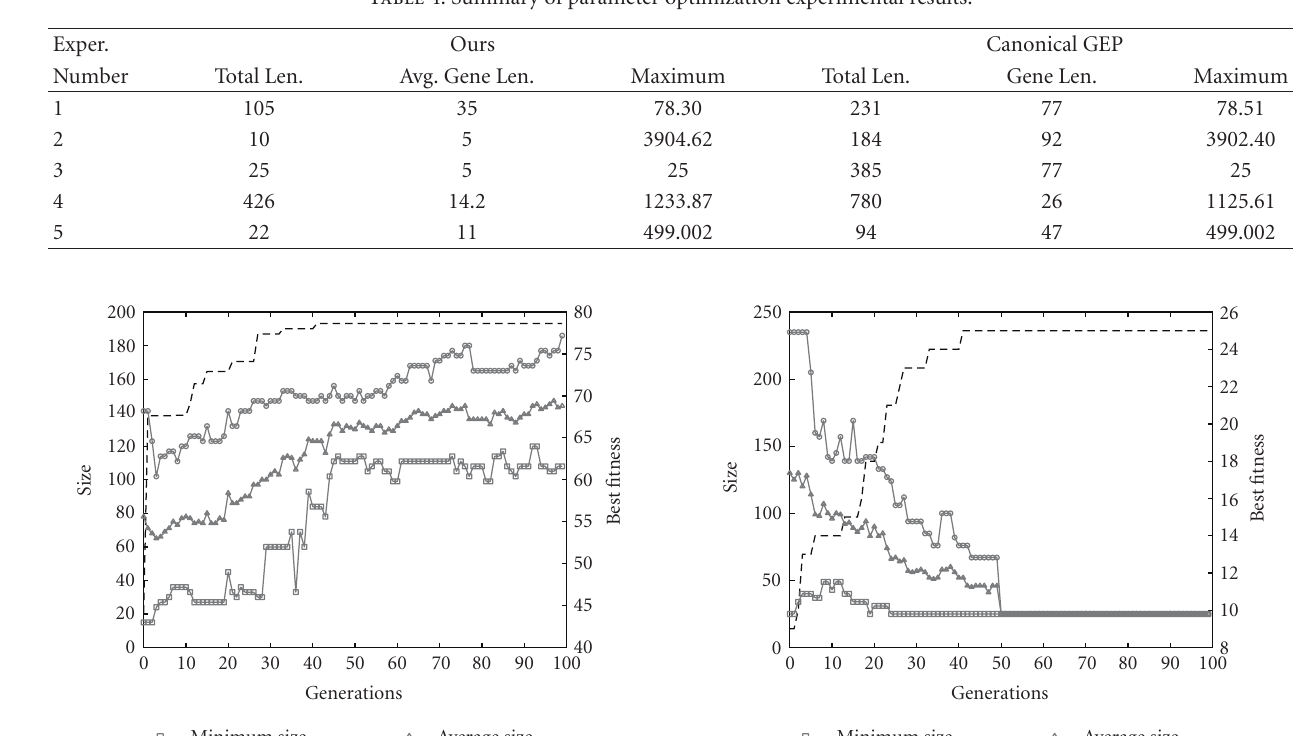
Table 4: Summary of parameter optimization experimental results.